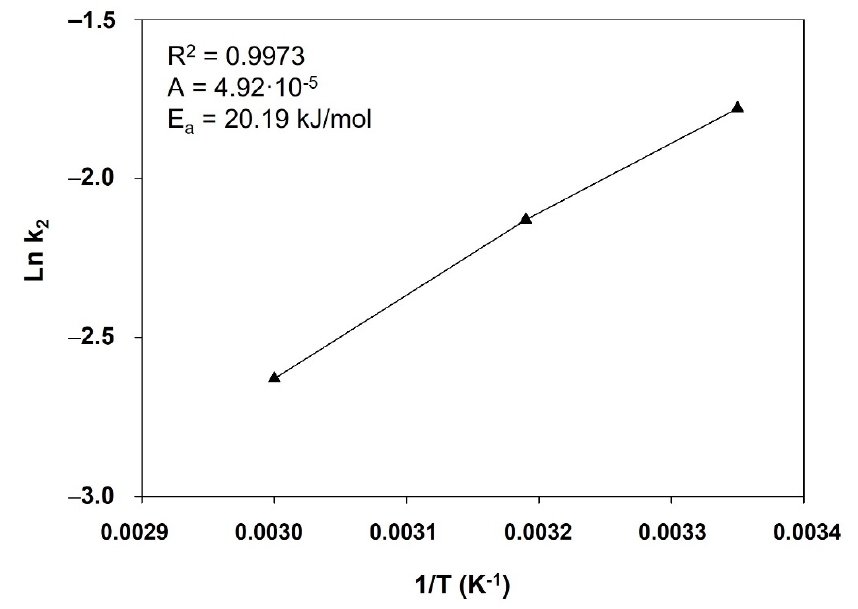
Figure 4. Variation of ln k 2 versus the inverse of temperature.